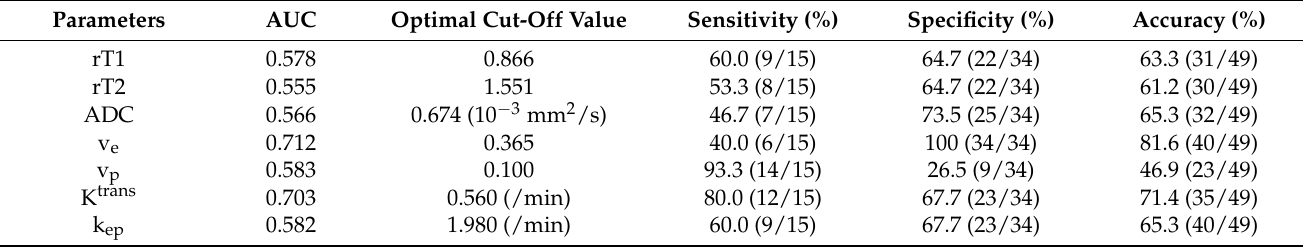
Figure 5. Receiver operating characteristic curve of each parameter for differentiating hard adenomas from soft adenomas (34 soft adenomas and 15 hard adenomas). rT1: ratio of signal intensity on T1-weighted MRI; rT2: ratio of signal intensity on T2-weighted MRI; ADC: apparent diffusion coefficient; v e : volume of extravascular extracellular space per unit volume of tissue; v p : blood plasma volume per unit volume of tissue; K trans : volume transfer constant between blood plasma and extravascular extracellular space; k ep : rate constant between extravascular extracellular space and blood plasma. Table 8. Diagnostic performance of MRI parameters in detecting hard